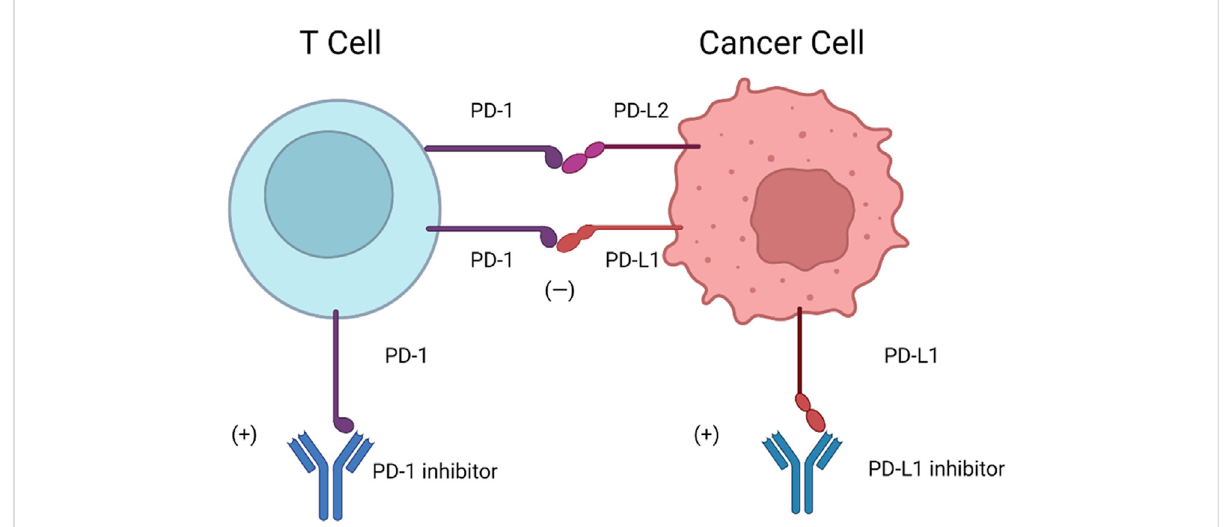
Mechanisms of PD-1-PD-L1/PD-L2. Cancer cells are highly capable of PD-L1 expression, which can inhibit the immune function of T cells in response to PD-L1 and PD-1 binding. Therefore, anti-PD-1 and anti-PD-L1 are considered promising strategies to stimulate “ exhausted ” T cells and eliminate tumors. PD-L2 is similar to PD-L1 in structure, has some sequence homology inhibits the function of T cell inhibition via